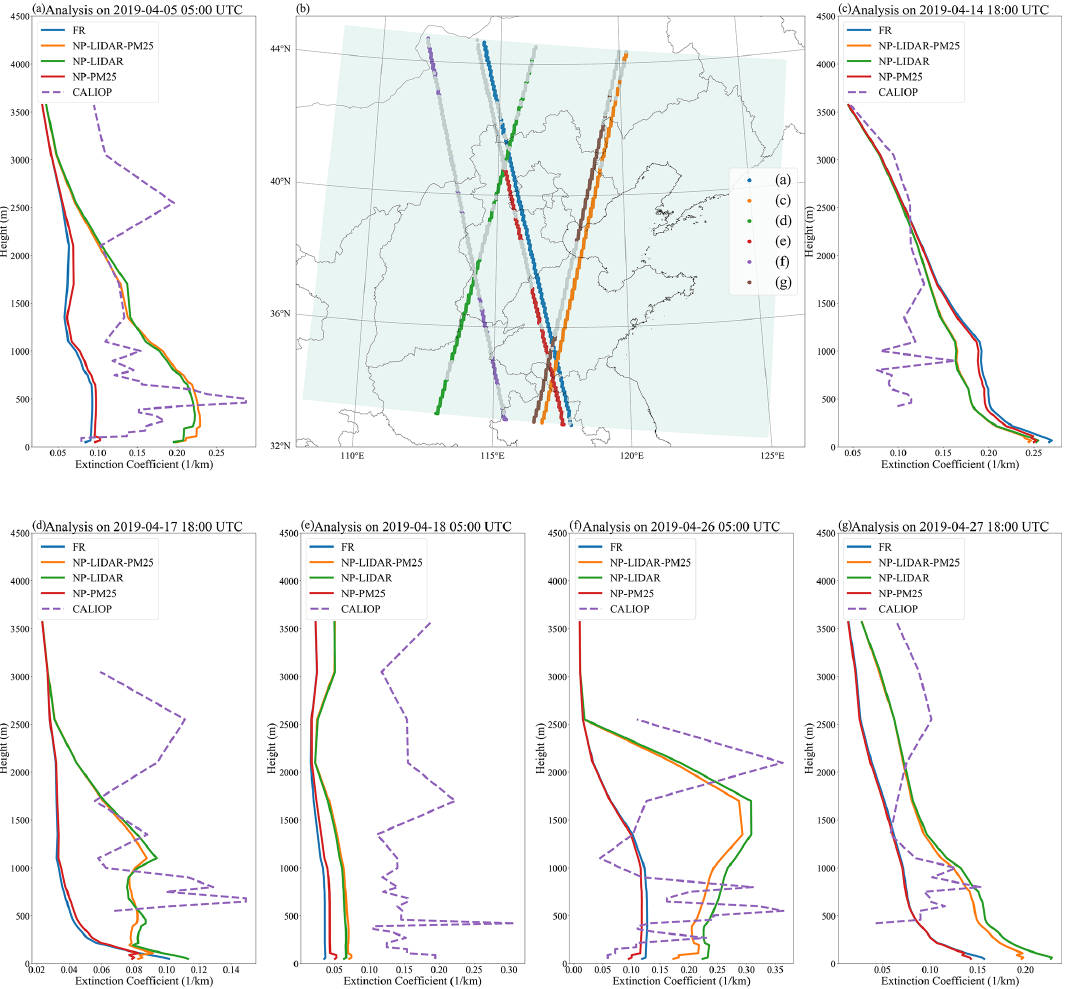
Figure 12. The extinction coefficient vertical profile of CALIOP measurement and analysis of the FR, NP-PM25, NP-LIDAR, and NP- LIDAR-PM25 experiments at 05:00UTC on 5 April 2019 (a) , 18:00UTC on 14 April 2019 (c) , 18:00UTC on 17 April 2019 (d) , 05:00UTC on 18 April 2019 (e) , 05:00UTC on 26 April 2019 (f) , and 18:00UTC on 27 April 2019 (g) . The CALIPSO orbit paths are also shown (b) . The shaded area denotes the model domain, and the gray lines (b) denote the part of orbits with missing extinction coefficient data through the vertical